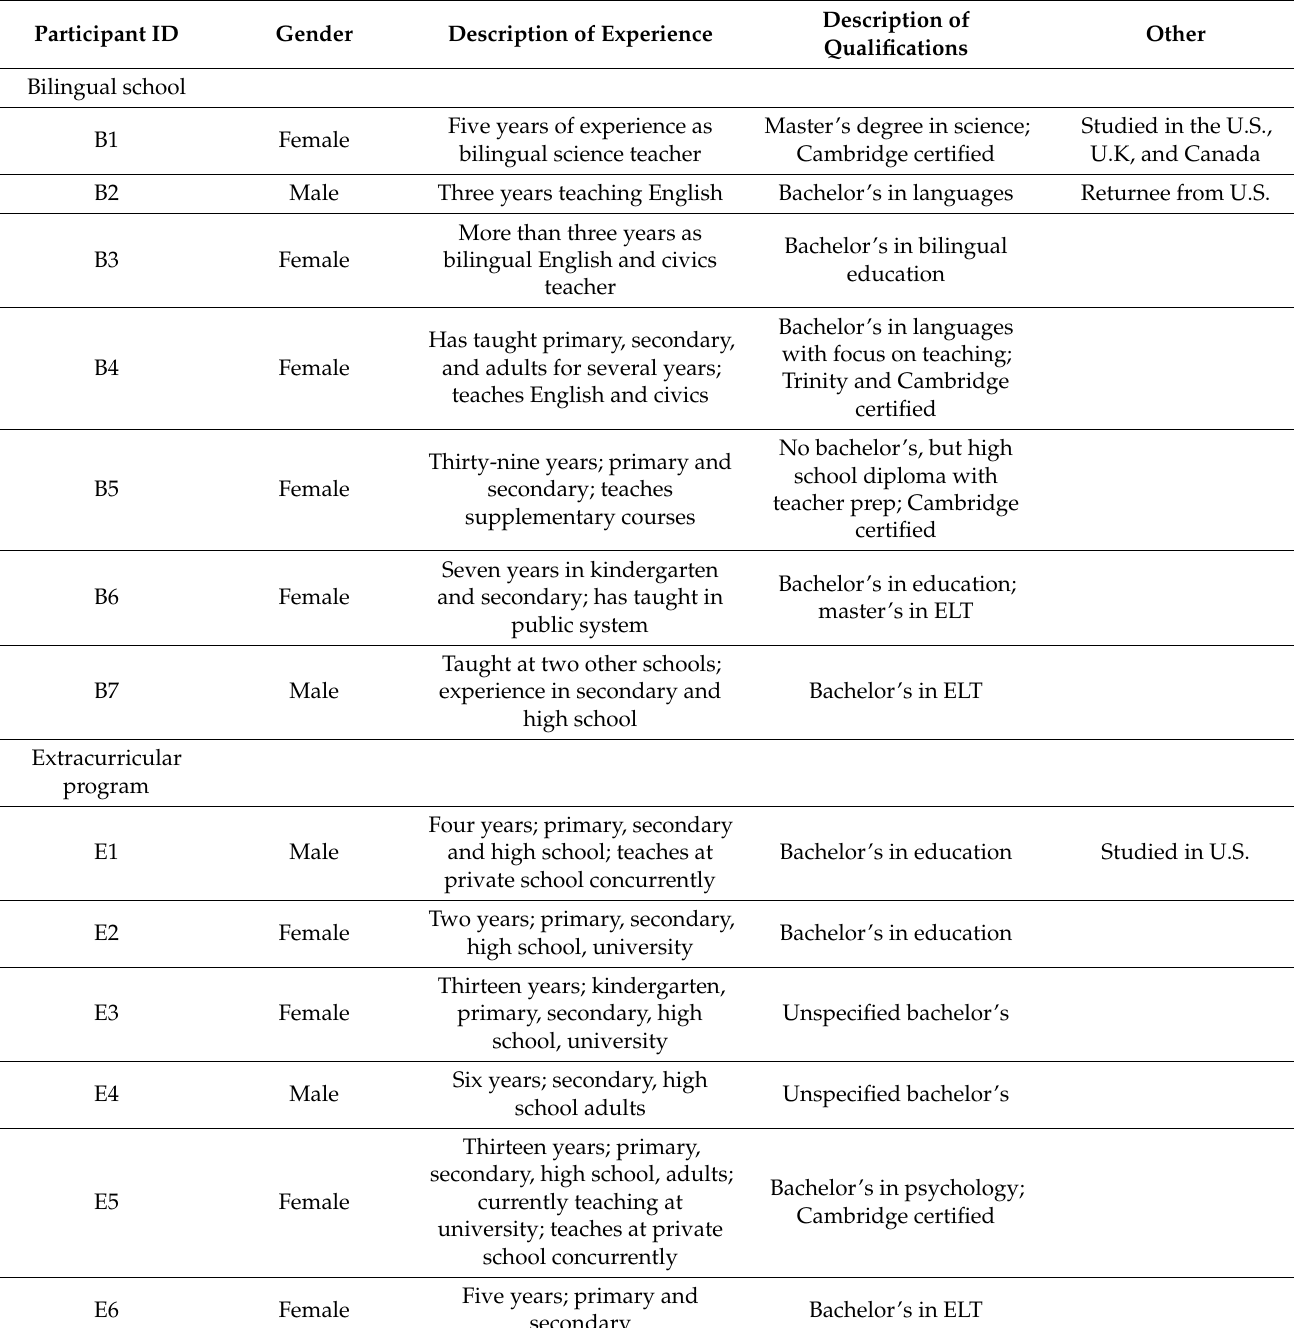
Table A1. Description of interview